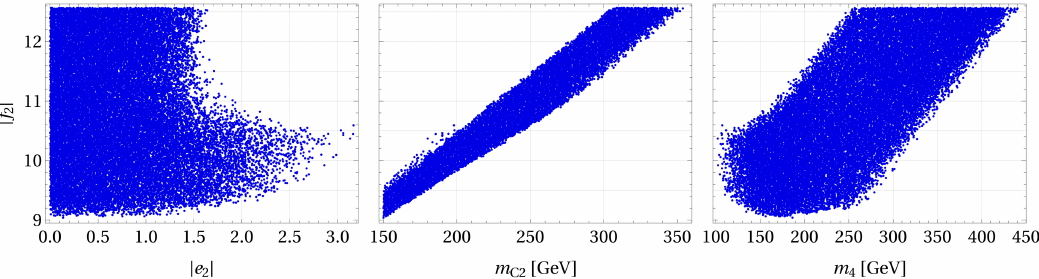
Figure 11 . Scatter plot of 2HDM points that obey the S - and T -oblique parameters constraints, fit solution 2 average at the 1 σ level, and have m